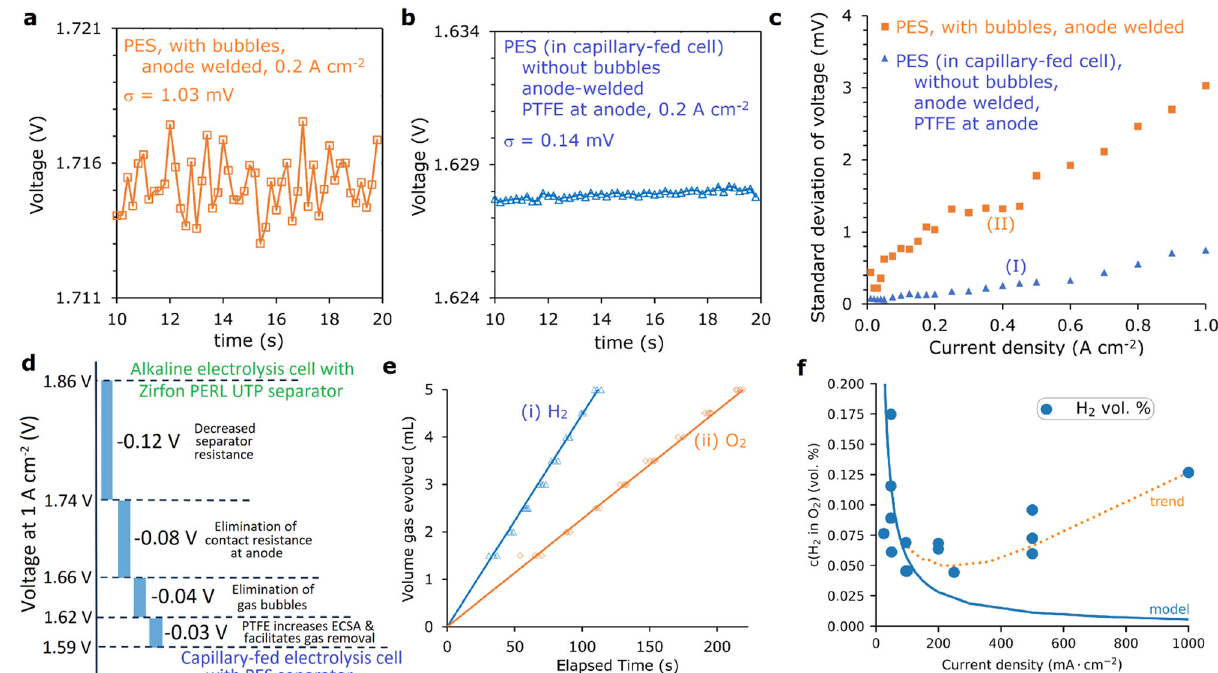
Fig. 4 Capillary-fed electrolysis cell characterisation. (At room temperature with 27wt% KOH unless stated otherwise). a Voltage pro fi le due to bubble formation. Voltage fl uctuations in the bubbled, control cell in Fig. 3b(v) over the last 10s of a 20s step at 0.2 Acm − 2 ( σ = standard deviation). b Voltage pro fi le in the capillary-fed cell. Voltage fl uctuations in the cell in Fig. 3b(i) over the last 10 s of a 20s step at a fi xed 0.2 Acm − 2 . c Voltage pro fi le uniformity as a function of current density. Plot of the standard deviation in voltage for the cells in: (I) Fig. 3b(i), and (II) Fig. 3b(v), at different current densities, each held for 20s, with the standard deviation measured over the last 10s of the 20s period. The bubbled control cell in Fig. 3b(v) displays much larger fl uctuations in voltage due to bubble formation than the capillary-fed cell in Fig. 3b(i), which exhibits largely bubble-free operation at ≤ 0.2A cm − 2 , and substantially bubble-free operation at 0.25 – 1 Acm − 2 . d Voltage declines and their origins. Waterfall plot showing the voltages declines observed at 1 Acm − 2 (80°C) and their sources. e Faradaic ef fi ciency. Rates of: (i) hydrogen generation, and (ii) oxygen generation by the capillary-fed electrolysis cell in Fig. 3b(i), at a fi xed 0.350A/cm 2 at atmospheric pressure, after 30 min. The data points indicate the measured volumes. The solid lines plot the theoretical rate of gas generation at 100% Faradaic ef fi ciency. The overall Faradaic ef fi ciency of the cell, determined by comparing the slopes of the measured and theoretical data, including both gases, was 99.5 ±1.3%. f Hydrogen crossover. The data points show the hydrogen crossover into the anodic oxygen stream of the capillary- fed electrolysis cell in Fig. 3b(i) as a function of current density, at room temperature and atmospheric pressure. Each data point was collected after operating the cell for 30 min at the relevant current density. The solid line shows the gas crossover expected from diffusion only 31,32 . The dashed line depicts the trend in the